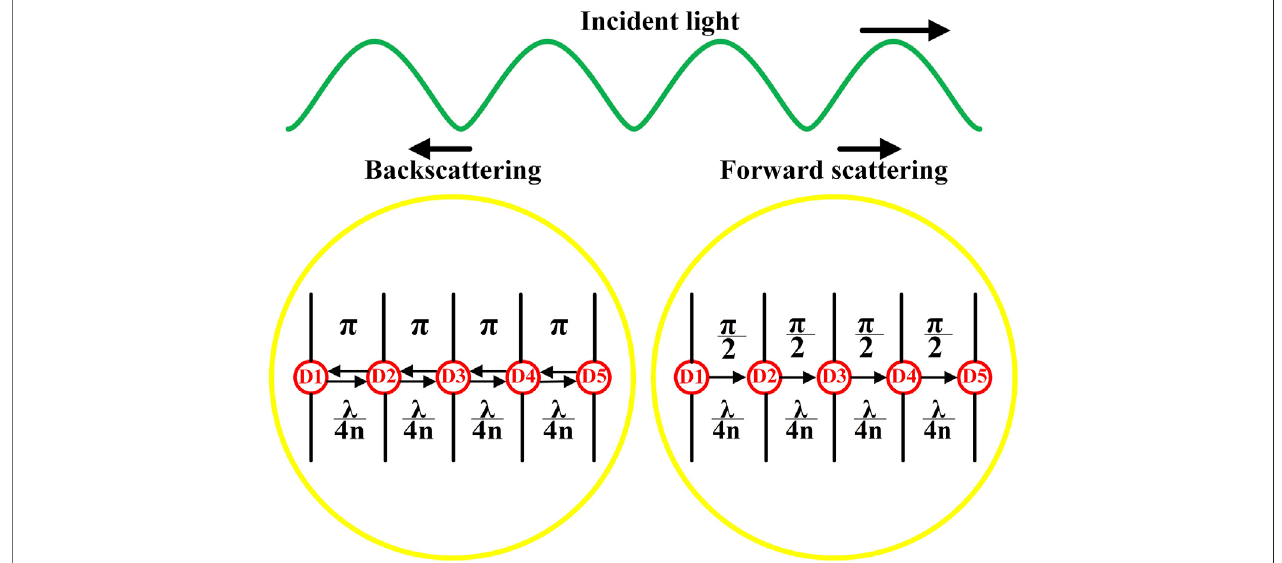
FIGURE 4 | Schematic of light emission by dipoles. D1, D2, D3, D4, and D5 are dipoles.